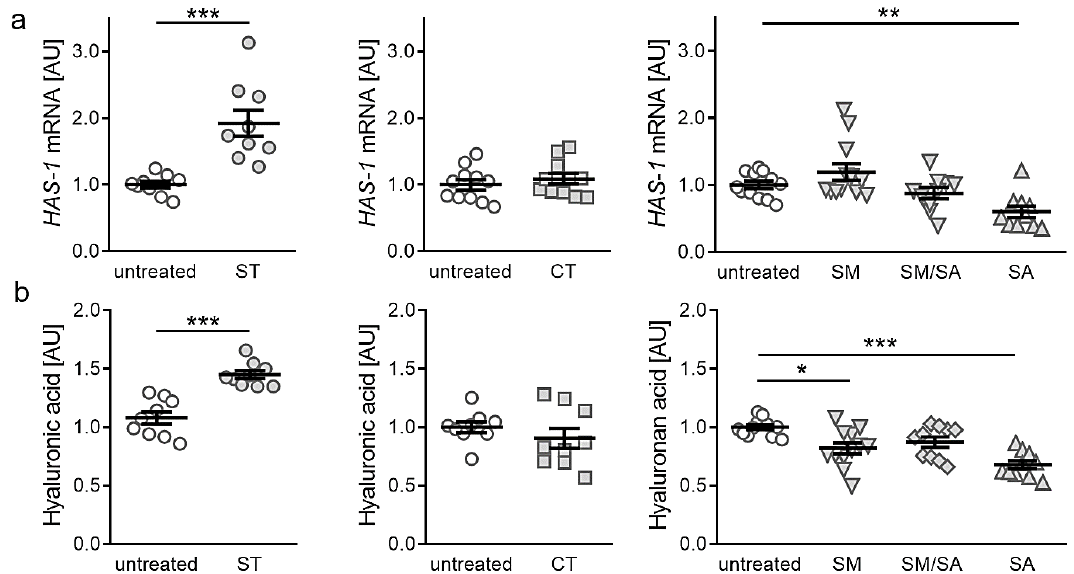
Figure 5. Expression of HAS-1 ( a ) and hyaluronic acid fraction content in cell culture supernatant ( b ) after application of different tensile strain protocols (explanation see manuscript text). AU: arbitrary units, error bars represent standard error of the mean. n > 8; Statistics: ST/CT: Mann-Whitney-U tests; SM, SM/SA, SA: Welch-corrected ANOVA with Games-Howell posthoc tests; * p < 0.05, ** p < 0.01, *** p < 0.001.